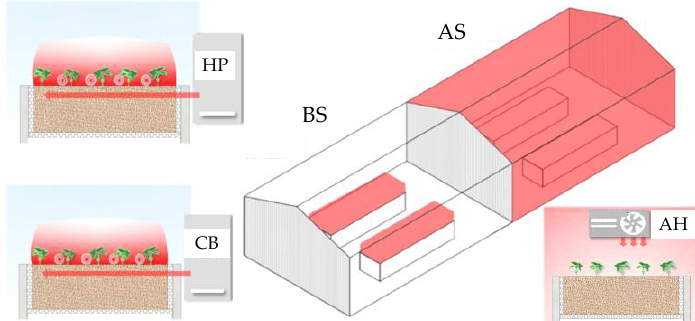
Figure 3. Schematic layout of the experimental test.